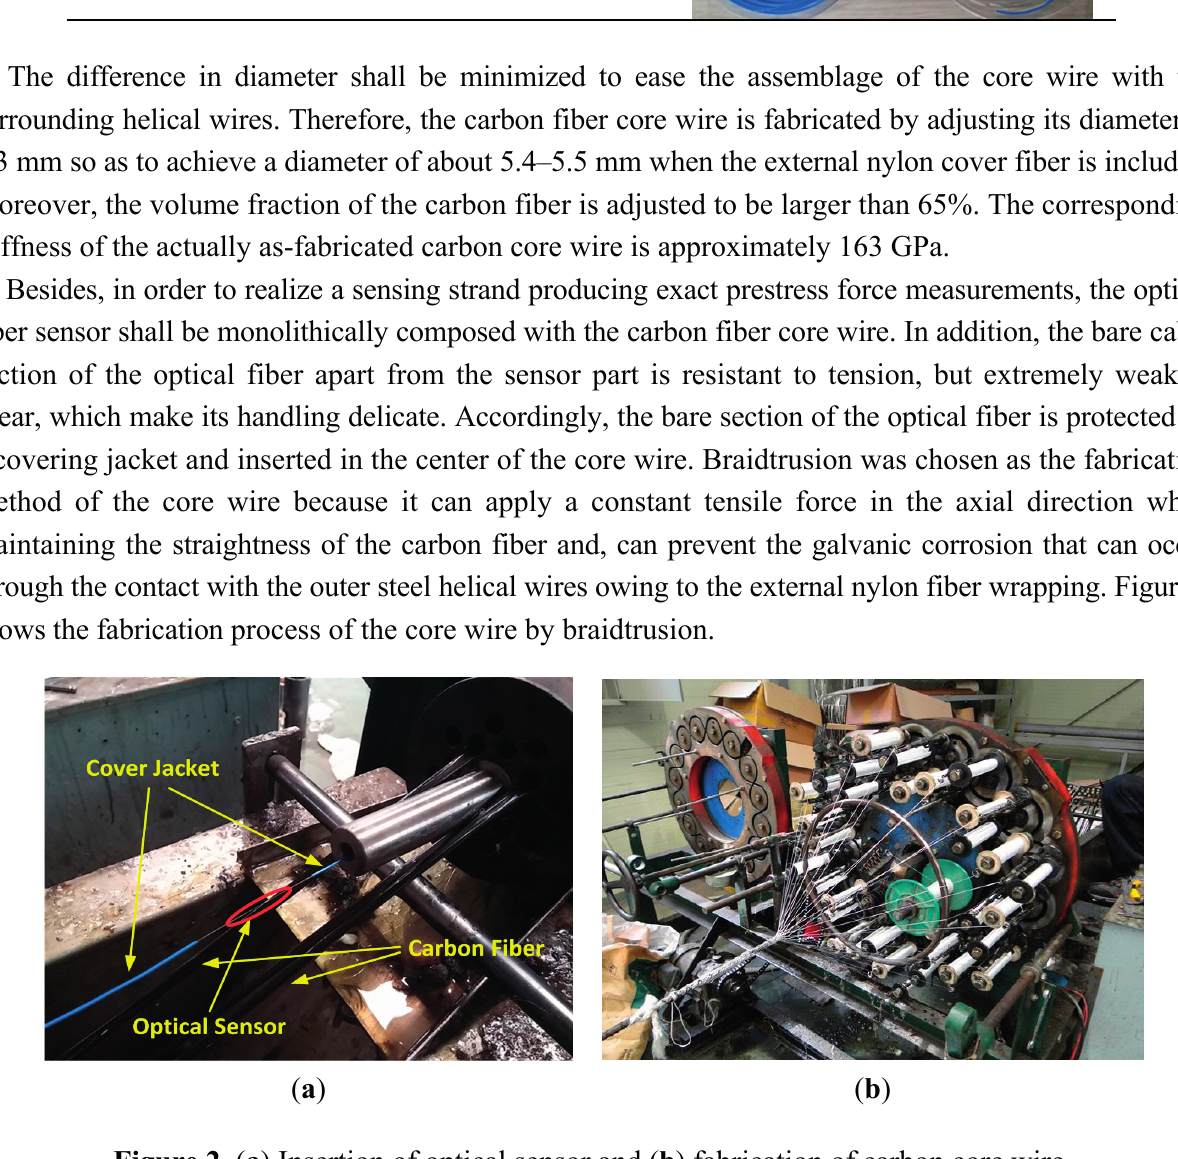
Figure 2. ( a ) Insertion of optical sensor and ( b ) fabrication of carbon core